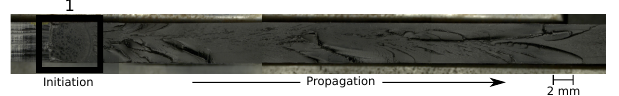
Figure 3. Observation by light microscopy of the fracture surface of sample B3. Zone 1 represents the crack initiation zone. The arrow indicates the direction of propagation.